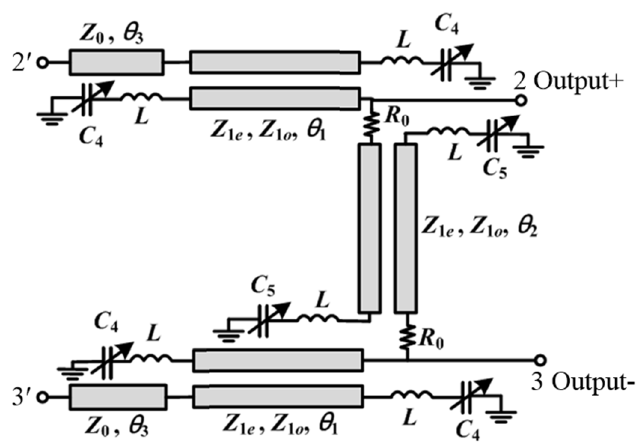
Figure 7. The schematic of the equivalent transmission line and IsC.